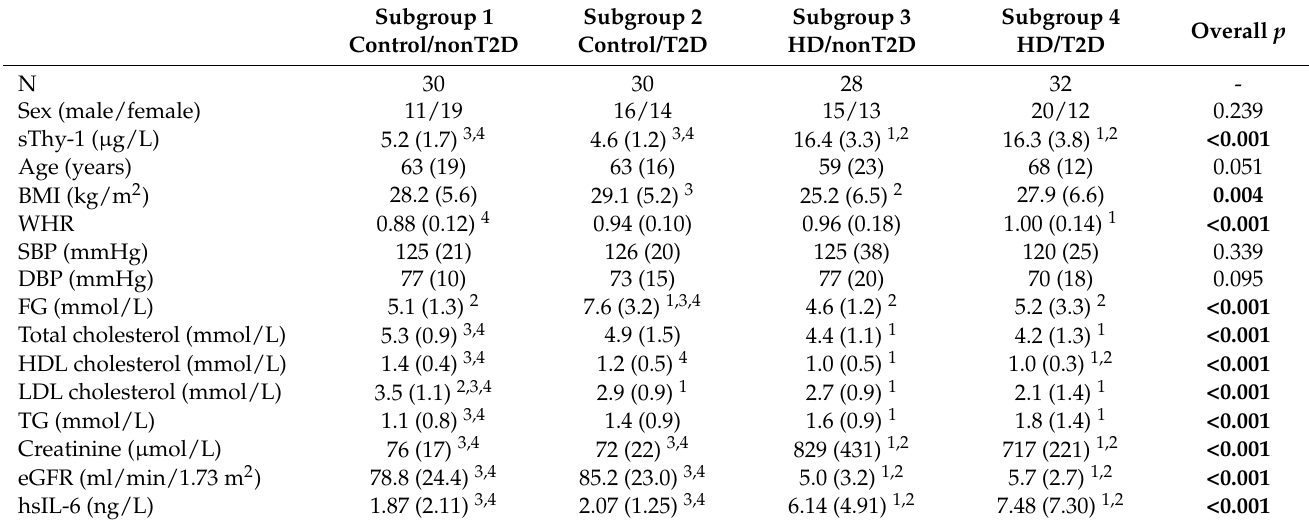
Table 1. Baseline characteristics of the study population in cohort 1 (N =